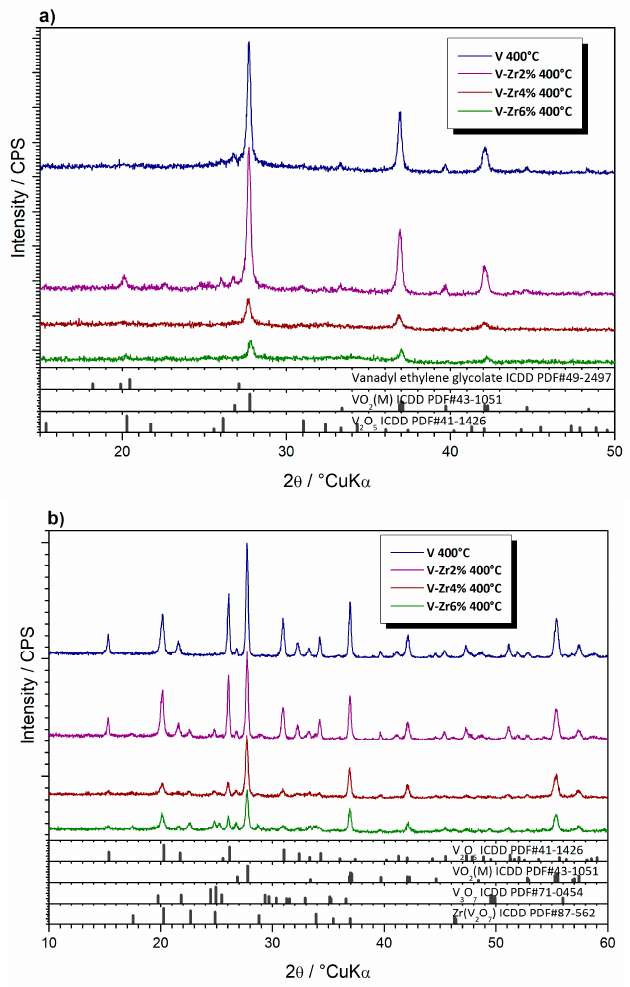
Figure 12. X-ray di ff raction patterns of the pure V to V-Zr6% powder samples thermally treated at Figure 12. X-ray diffraction patterns of the pure V to V-Zr6% powder samples thermally treated at 400 ◦ C for ( a ) 5, ( b ) 10 400 °C for ( a ) 5, ( b ) 10 min. Table 2. Properties of the samples. Thermochromic smart window parameters of all powder samples—pure vanadia and Zr-doped vanadia (2, 4, 6%) (annealed at 400 °C for 5 min)—and film samples—pure vanadia, Zr-doped vanadia (2%) and Ce-doped vanadia (2%) (annealed at 100 °C for 360 min). The amount of “•” symbolises an arbitrary unit representing purely empiric interpretation of combination of all investigated factors and parameters that are prerequisite for achieving thermochromic quality. Sample